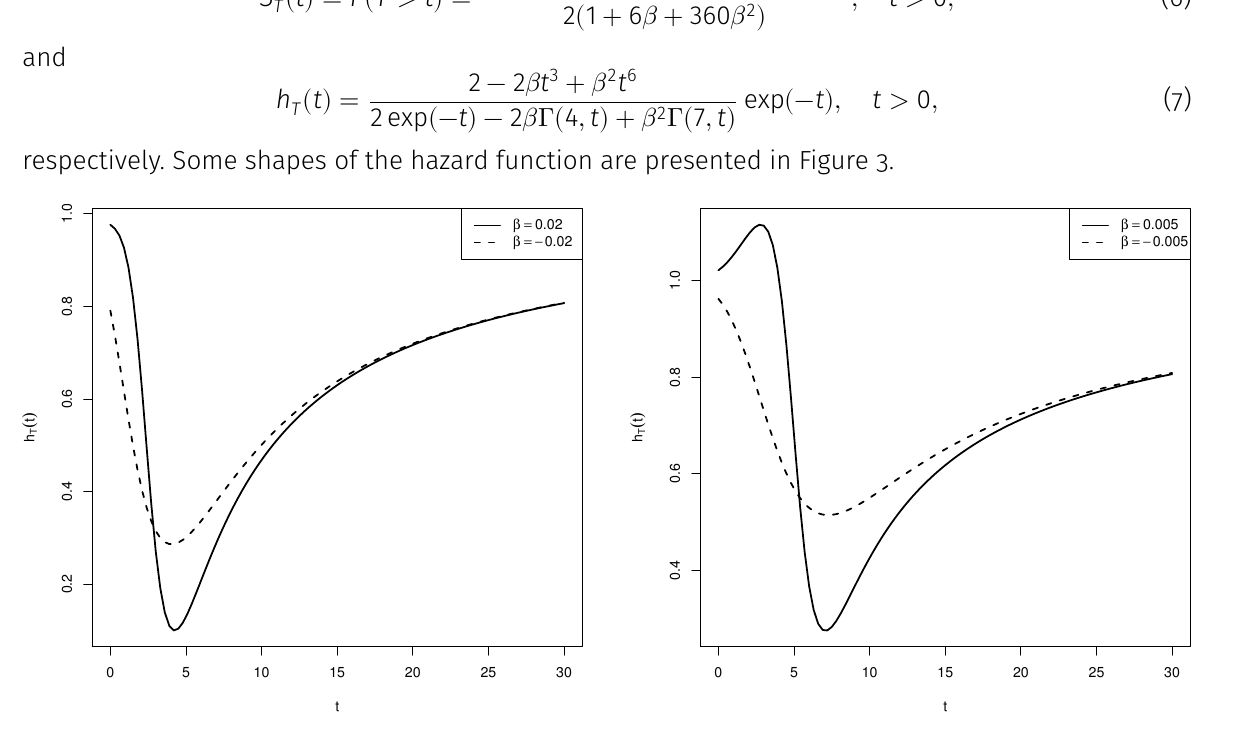
Figure 3. Illustrations of the hazard rate of BSL (𝜷) for selected values of 𝜷